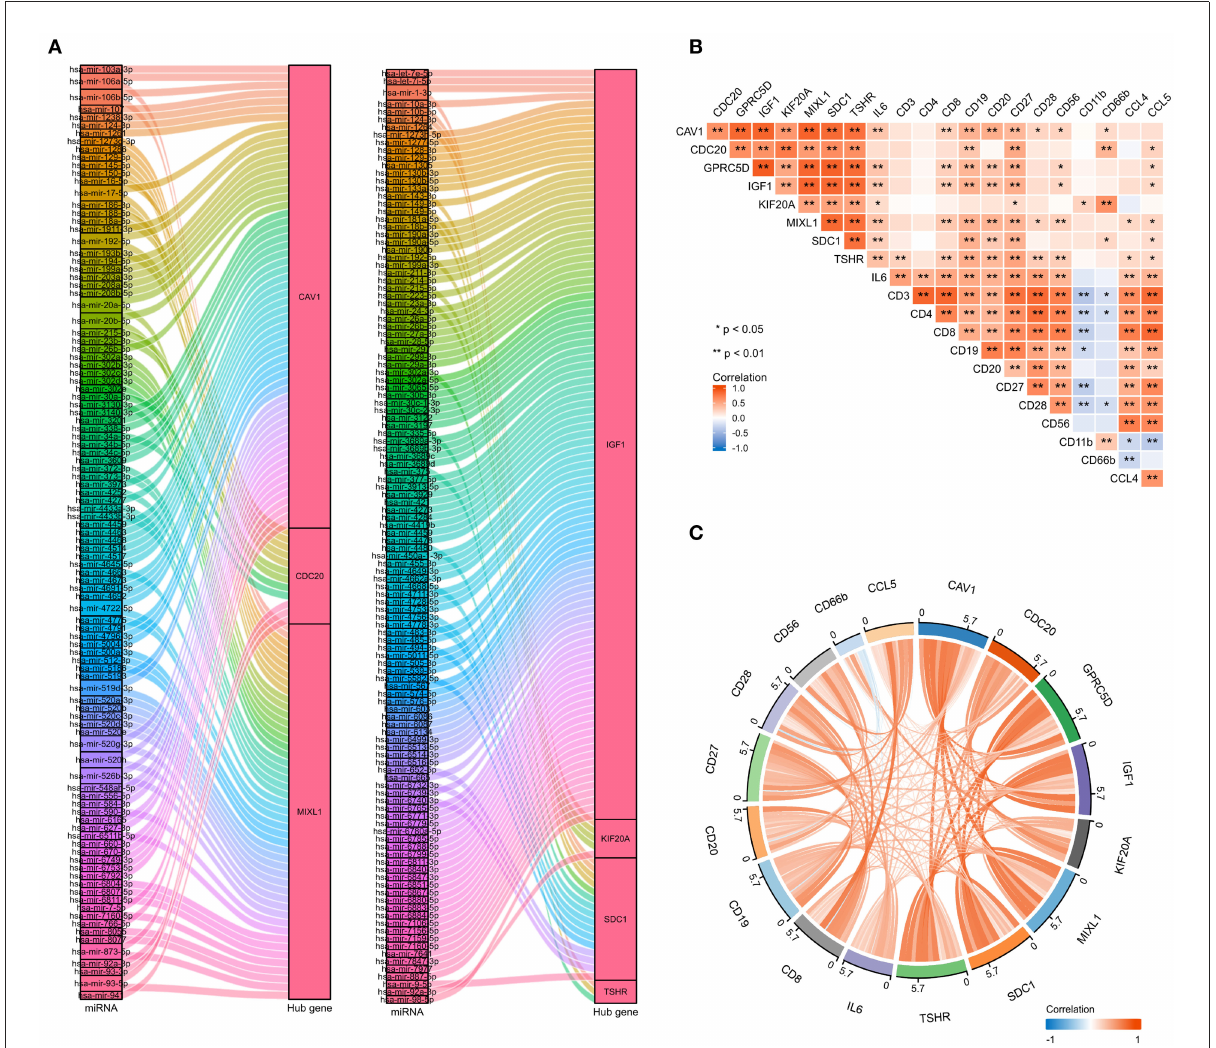
FIGURE7 The mRNA-miRNA co-expressed interaction network constructed by Cytoscape and the correlation between hub genes and immunocyte-related molecular markers. (A) The mRNA-miRNA co-expressed networks including 230 target miRNAs for 7 hub genes, the prediction information for the GPRC5D gene was lacking in the NetworkAnalyst database. (B) The expression correlation among hub genes (CAV1, CDC20, GPRC5D, IGF1, KIF20A, MIXL1, SDC1, and TSHR), IL-6, and immunocyte-related genes (CD3, CD4, CD8, CD19, CD20, CD27, CD28, CD56, CD11b, CD66b, CCL4, and CCL5). Correspondence between biomarkers and immunocyte types: CD3: T cells; CD4: helper T cells; CD8: cytotoxic T cells; CD19, CD20, and CD27: B cells; CD28: activated T cells; CD56: natural killer cells; CD11b and CD66b: activated neutrophils. (C) The expression correlation among hub genes, IL-6, CD3, CD8, CD19, CD20, CD27, CD28, CD56, CD66b, and CCL5, had high correlations with hub genes. The red color indicates a positive correlation, and the blue color presents a negative correlation. * P < 0.05, ** P <